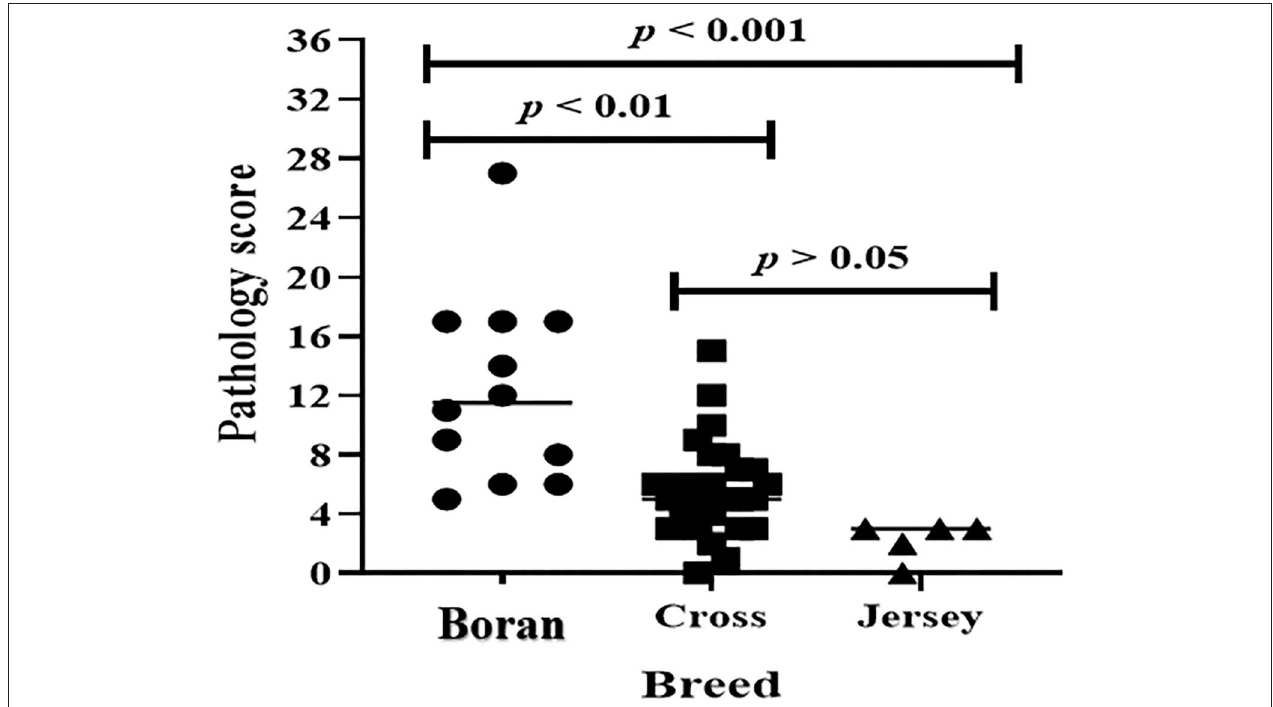
FIGURE 4 | Pathology score in 43 study animals. The horizontal lines show median pathology scores of each breed. The pathology score was compared in three breeds using Kruskal-Wallis statistical test with Dunn’s post-hoc multiple comparison test. There was significant [ χ 2 (2) = 18.78, p < 0.001] difference in pathology score among the three breeds. The difference was observed between the Boran and the cross breeds ( U = 13.91; p < 0.01) as well as between the Boran and the Jersey breeds ( U = 26.94; p < 0.001).